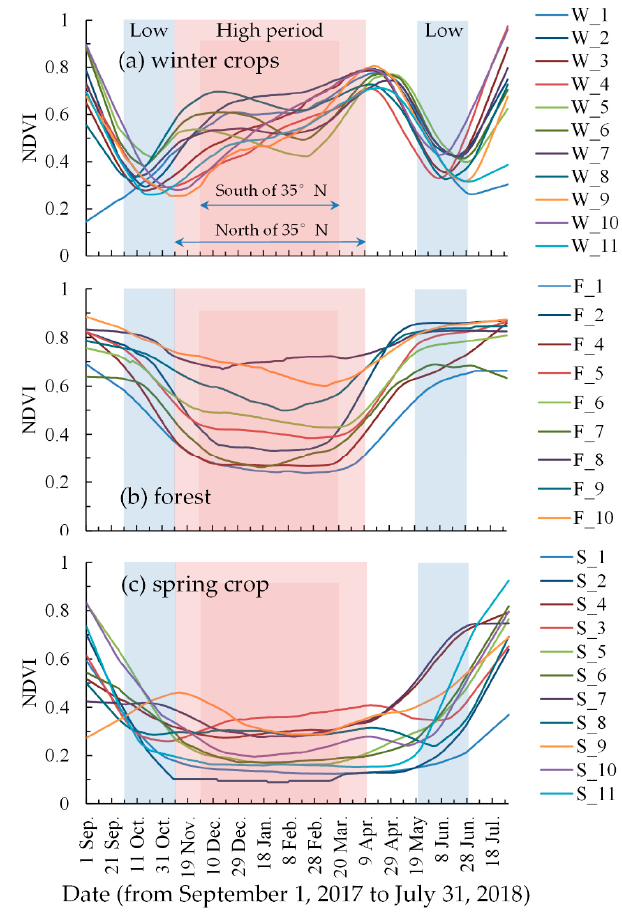
Figure 5. Moderate Resolution Imaging Spectroradiometer (MODIS) normalized difference vegetation index (NDVI) temporal profiles of different vegetation in different regions, from September 1, 2017 to July 31, 2018. The red background represents the period of high NDVI values and the blue background represents the period of low NDVI values.